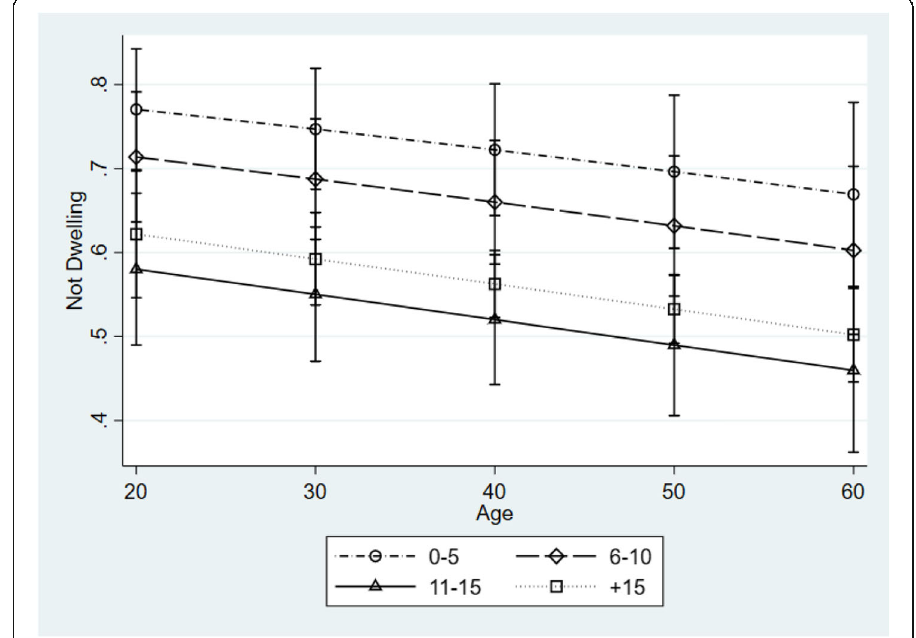
Fig. 4 Predictive margins of Unmatching dwelling and home by age and length of residence